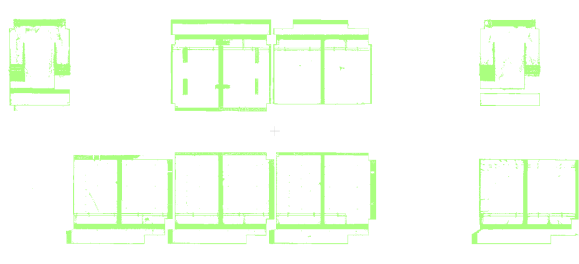
Figure 8 . The second floor of the divided building